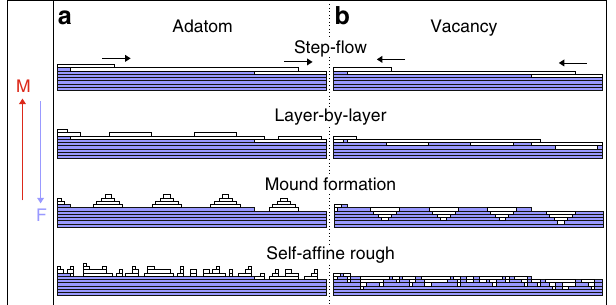
Fig. 1 Single-crystal growth regimes: a well-established regimes for adatom deposition and b newly proposed analogous regimes for vacancy generation during e.g. etching. In which particular regime the surface grows depends on the deposition fl ux, F , divided by the species surface-mobility, M , indicated by the arrows